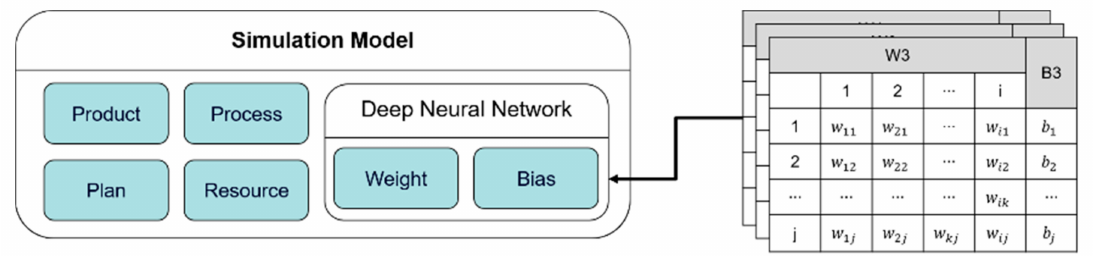
Figure 4. Configuration of simulation